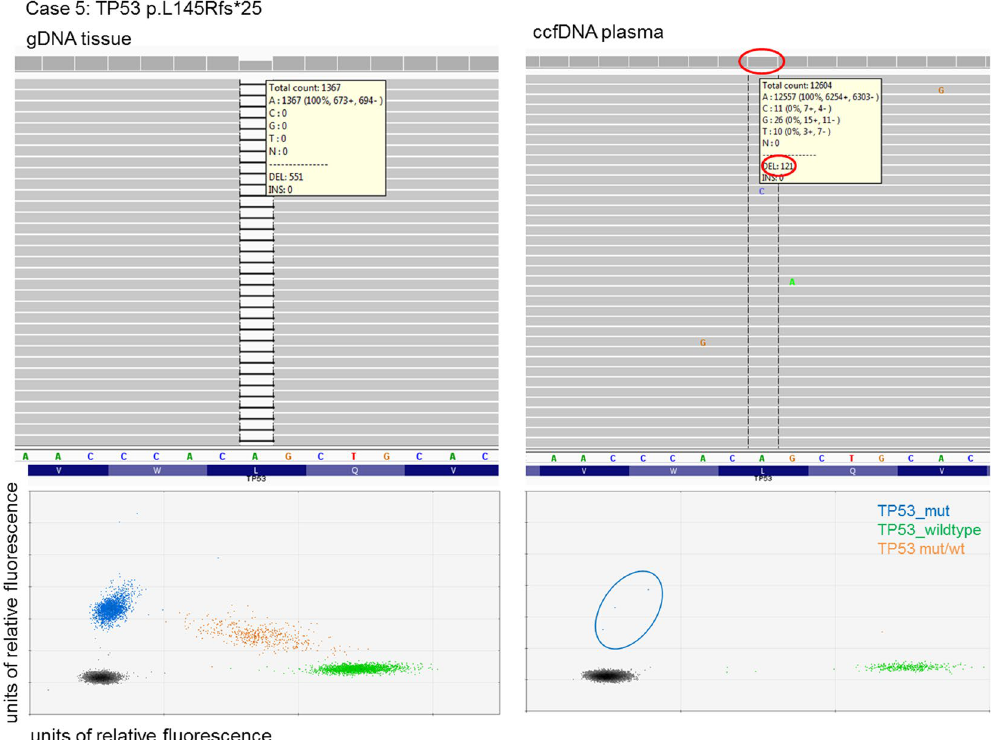
Figure 3. Visual representation of a single mutation in gDNA and ccfDNA. The upper panels show results from next-generation sequencing, whereas the lower panels show the same DNA analysed by digital PCR. The left panels show the mutation on genomic DNA, the right panels show the results from corresponding